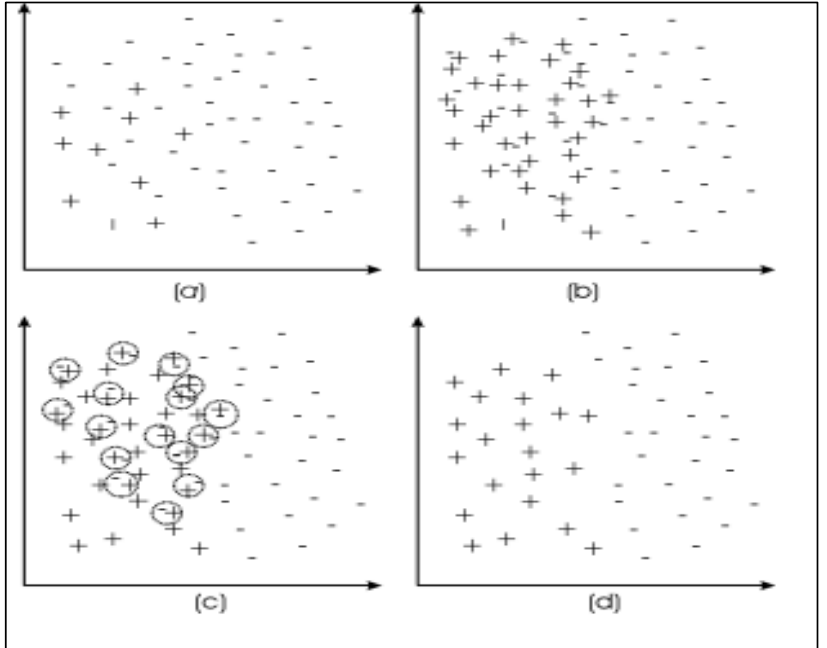
Figure 5. Balance the Dataset (( a ). Normal dataset; ( b ). Dataset oversampled; ( c ). Identified Tomek links; ( d ). Removed borderline and noise example) [16].